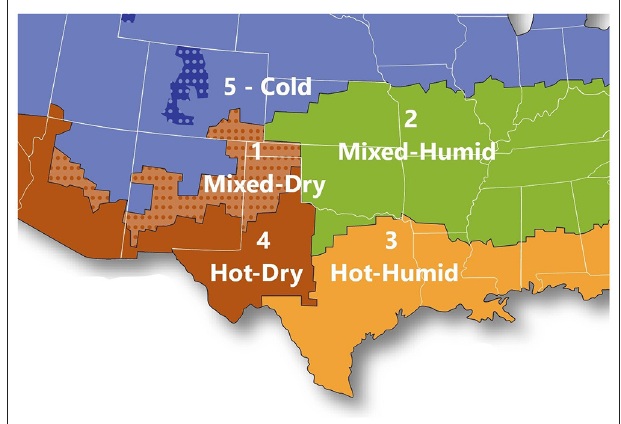
FIGURE 1 | Climate regions from which cattle originated. Adapted from (https://www.energy.gov/eere/buildings/building-america-climate-specific-